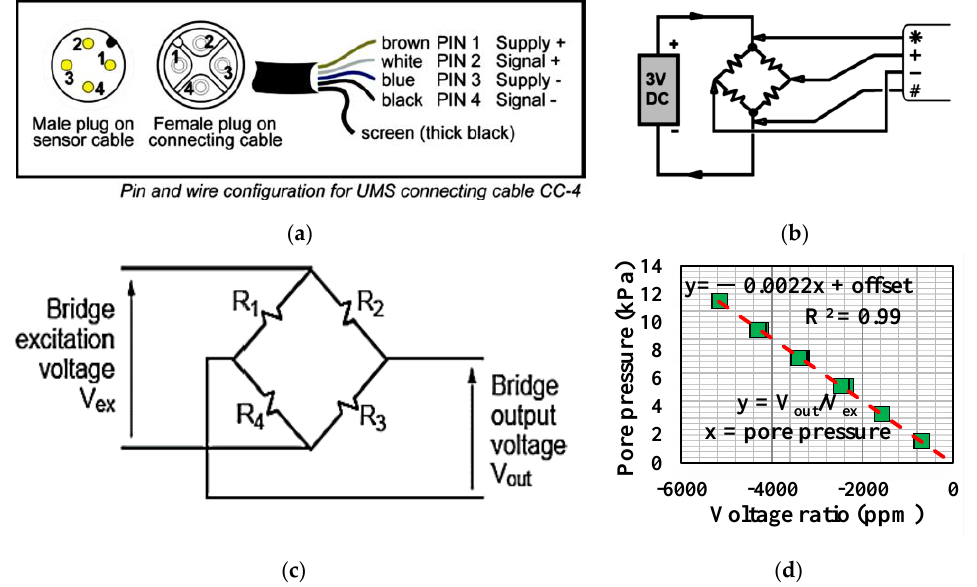
Figure 8. The connector configuration between the T5 sensor and logger analogue channel and corresponding signal processing between the voltage in/outputs from the T5 Wheatstone circuit and pore pressure: ( a ) the T5 sensor connector design; ( b ) the analogue channel on GeoLogger compatible with the Wheatstone circuit with an additional 3 V power supply; ( c ) the voltage in/outputs of Wheatstone circuit; ( d ) the linear calibration between voltage output and pore pressure [16,65,68].